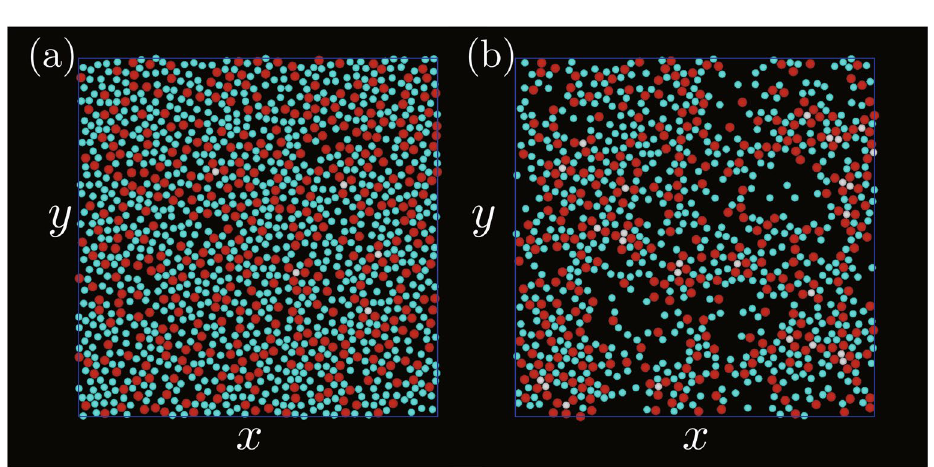
Figure 5. Snapshots of two-dimensional structure created on the bottom wall for ( a ) ε W = 4 ε AB and ( b ) ε AB , where he energy ratios ε AA /ε AB and ε BB /ε AB were both set to 0.1, and ε AB / k B T was the same as that in Fig.